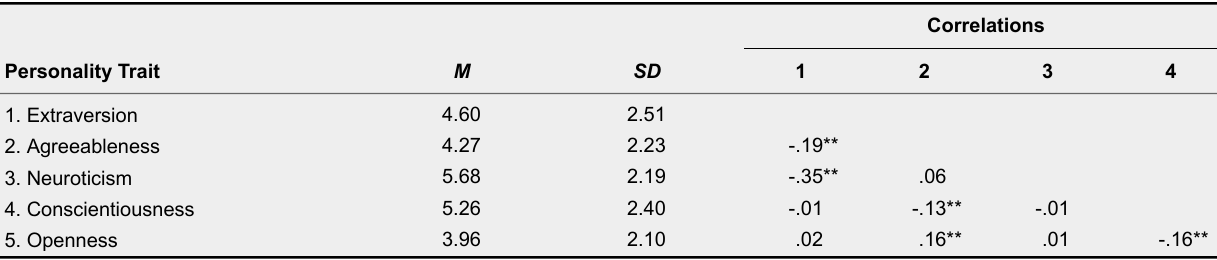
Perceived Big Five Personality Traits: Descriptive